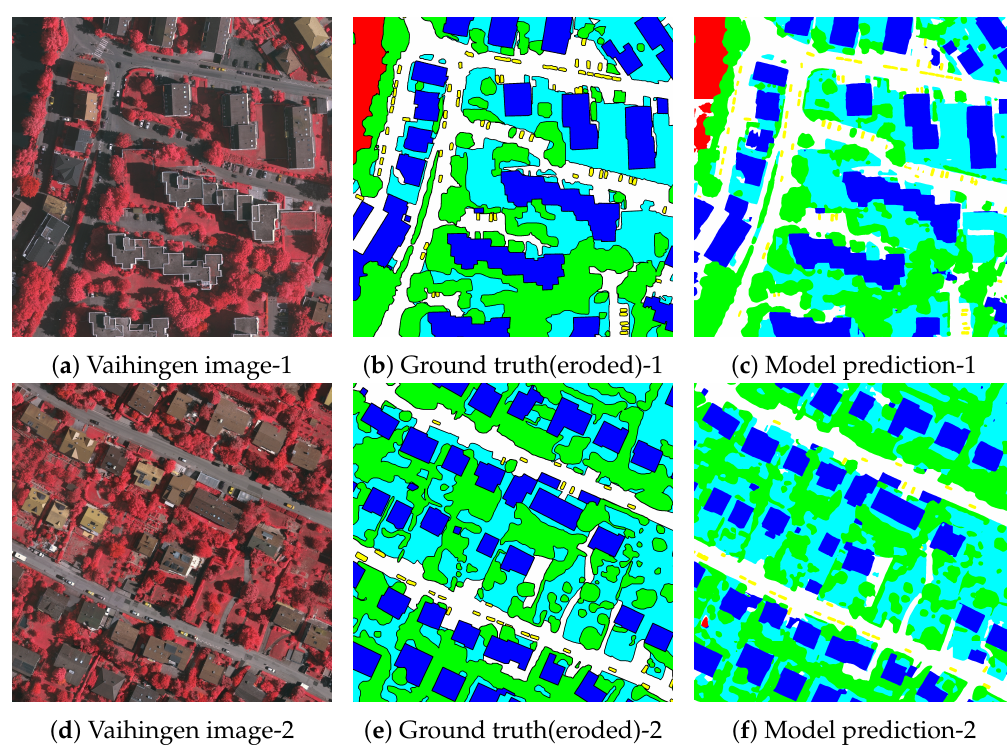
Figure 10. Visual results of benchamark evaluation on ISPRS Vaihingen dataset. Table 3. Benchmark evluation results on the ISPRS Vaihingen dataset (class F1 score and overall accuracy). Imp surf: impevious surfaces. Low veg: low